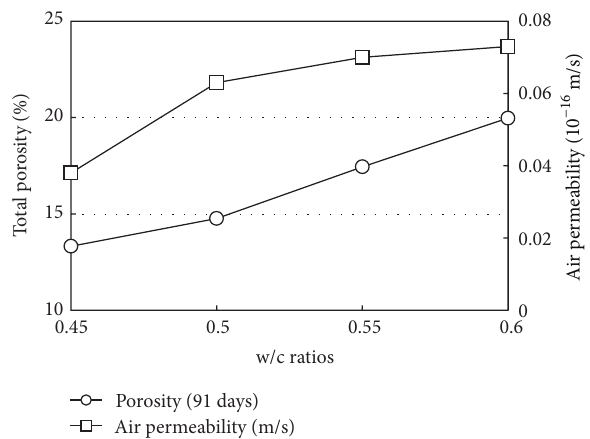
Figure 7: Air permeability and porosity with different W/C ratios.